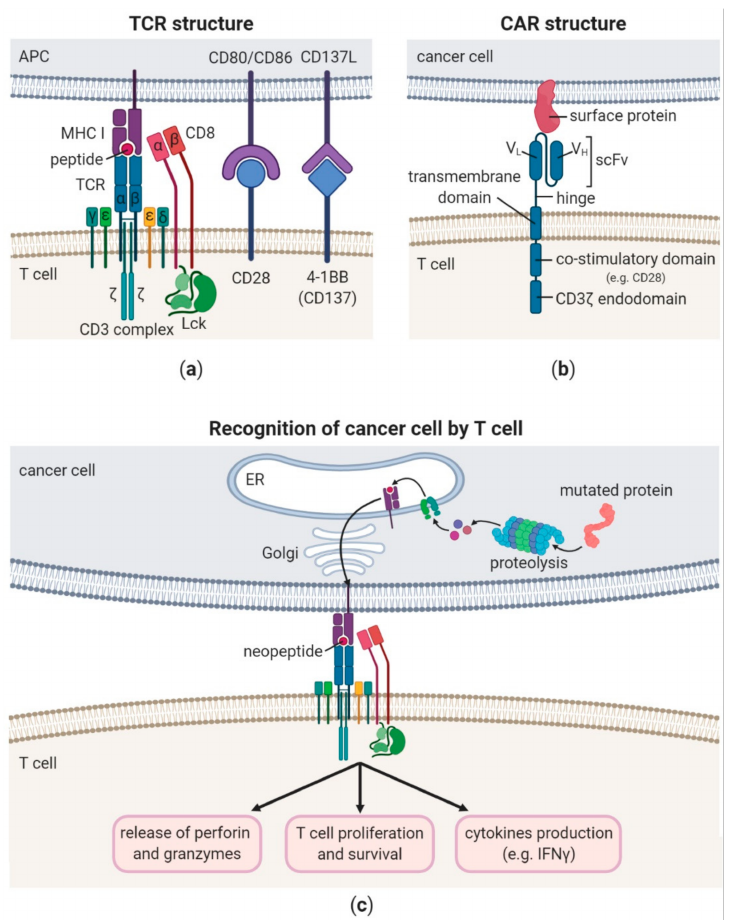
Figure 1. Comparison between T cell receptor (TCR) and chimeric antigen receptor (CAR) structure and signalling. ( a ) TCR interacts with CD3 complex (composed of two heterodimers CD3 γ / CD3 ε and CD3 δ / CD3 ε and a single homodimer CD3 ζ / CD3 ζ ). TCR recognises and binds a peptide presented by